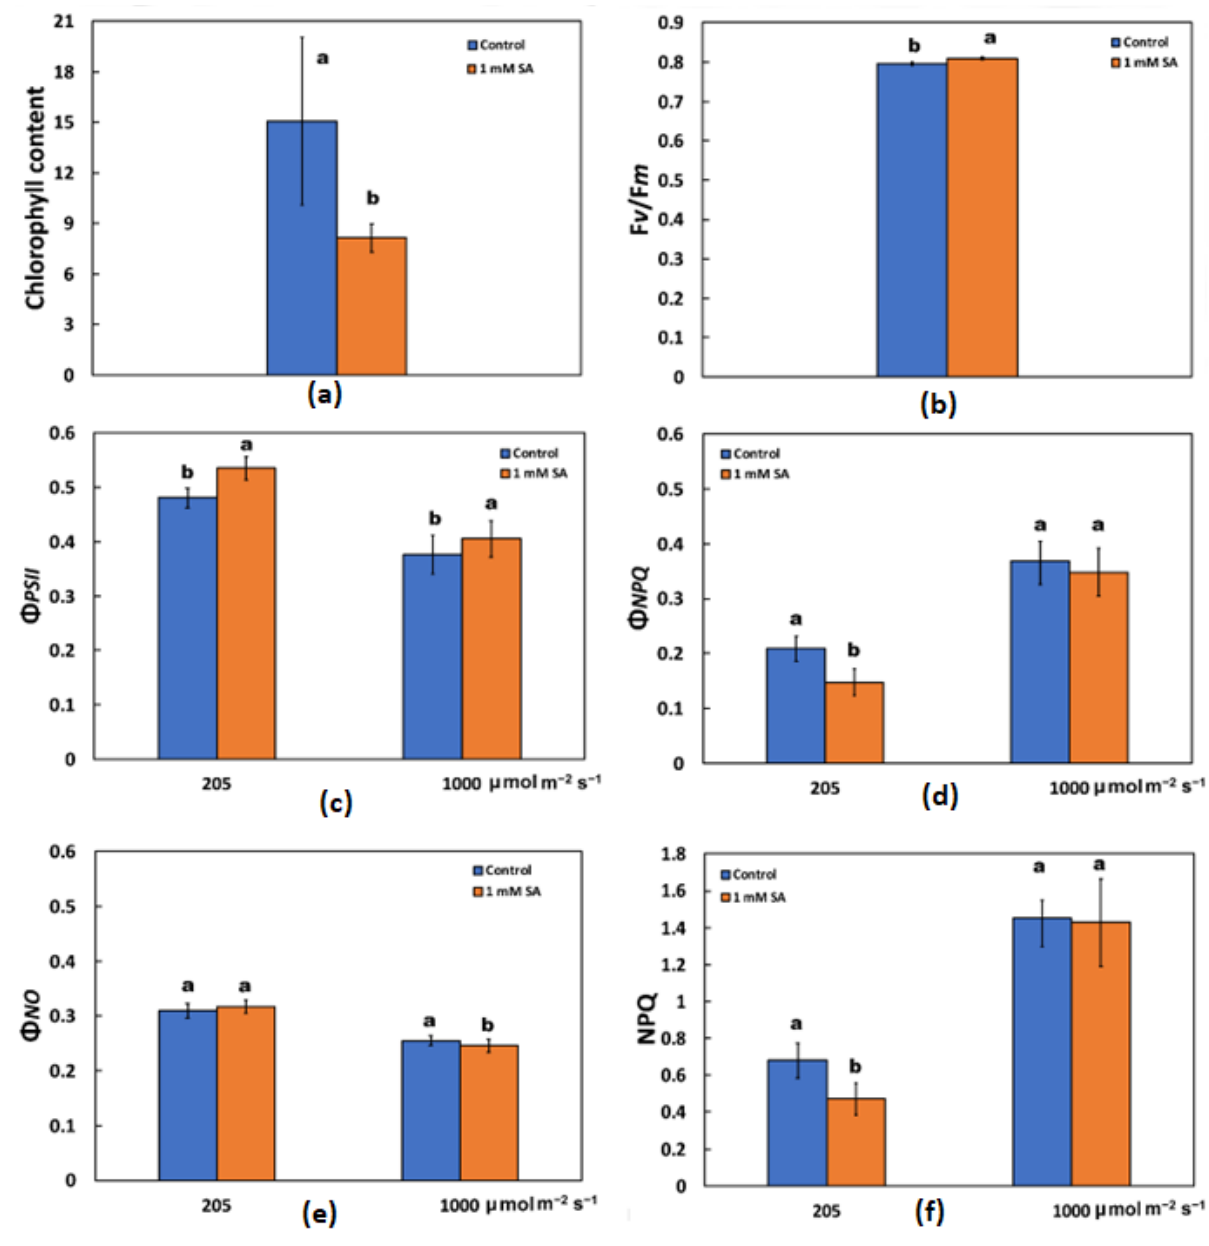
Figure 1. Chlorophyll contents, expressed in relative units ( a ); maximum efficiency of PSII pho- tochemistry (F v /F m ) ( b ); effective quantum yield of PSII photochemistry ( Φ PSII ) estimated at 205 and 1000 μmol photons m − 2 s − 1 actinic light (AL) intensity ( c ); quantum yield of regulated non-photo- chemical energy loss in PSII (Φ NPQ ) estimated at 205 and 1000 μmol photons m − 2 s − 1 AL intensity ( d ); quantum yield of non- regulated energy dissipated in PSII (Φ NO ) estimated at 205 and 1000 μmol photons m − 2 s − 1 AL intensity ( e ); and the non-photochemical quenching that reflects heat dissipation of excitation energy (NPQ) estimated at 205 and 1000 μmol photons m − 2 s − 1 AL intensity ( f ), in tomato leaves, after 72 h of foliar spray by either distilled water (control) or 1 mM salicylic acid (SA). Error bars are standard deviations ( n = 4). Columns with different lowercase letters are statistically differ- ent ( p < 0.05).